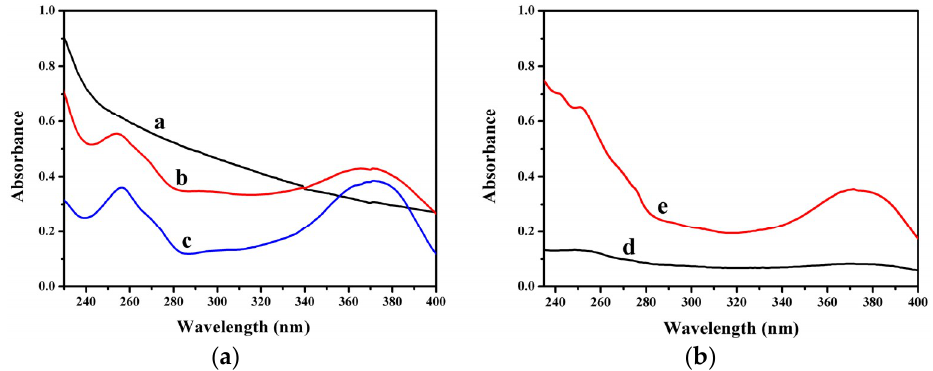
Figure 4. UV spectra of ( a ): three types of liquids, a: chitosan solution, b: quercetin-loaded nanoparticles suspension, c: quercetin–ethanol solution, and ( b ): ethanol solutions obtained from the HA/QTCs multilayer films with d: 5 and e: 10 bilayers.